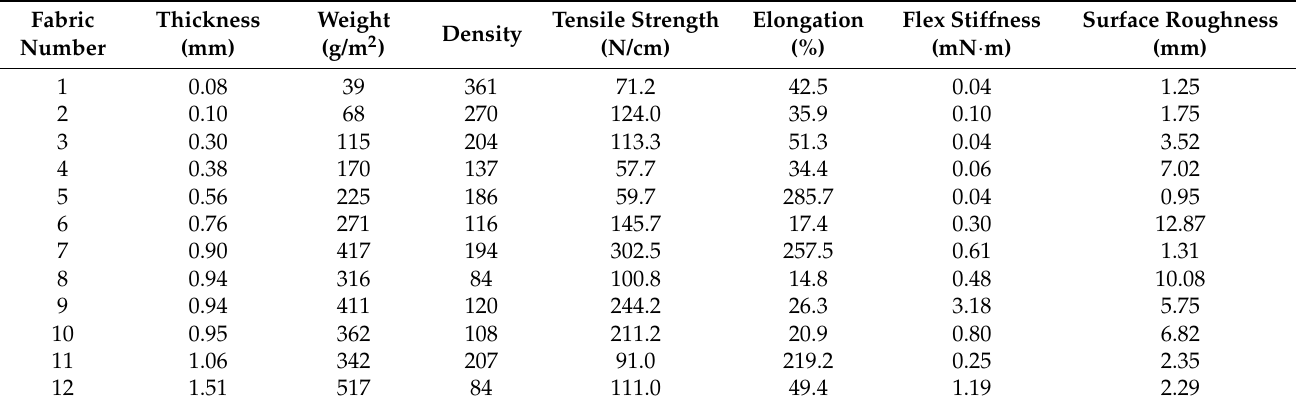
Table 6. Mechanical properties of the fabric